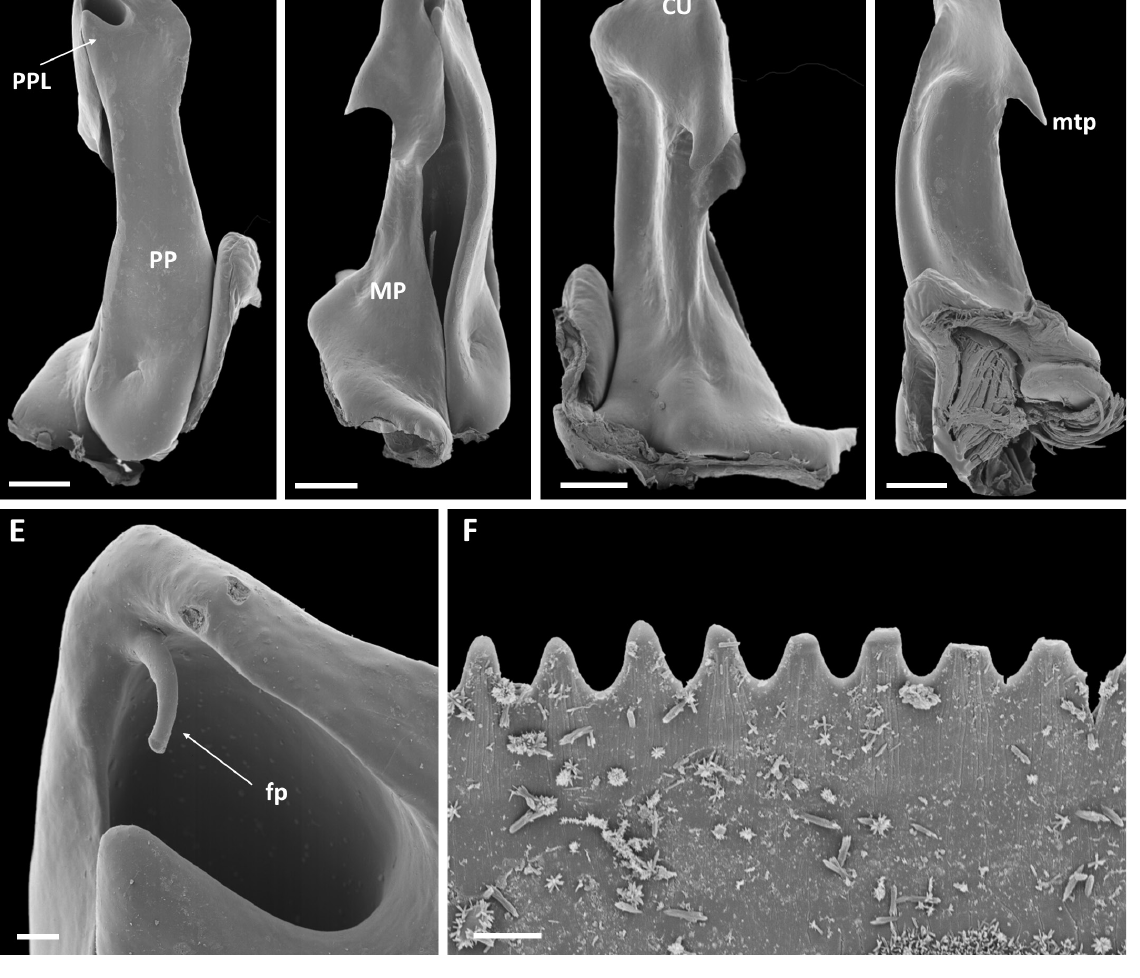
Fig. 15. Calyptomastix ingemanni sp. nov., holotype, ♂ (NHMD 621715). A–E . Right gonopod coxa. A. Anterior view. B. Mesal view. C. Posterior view. D. Lateral view. E. Cucullus. F . Midbody dorsal imbus. Abbreviations: CU = cucullus; fp = fingerlike process; MP = metaplica; mtp = metaplical triangular process; PP = proplica; PPL = proplical lobe. Scale bars: A–D = 0.2 mm; E = 0.02 mm; F = 0.01